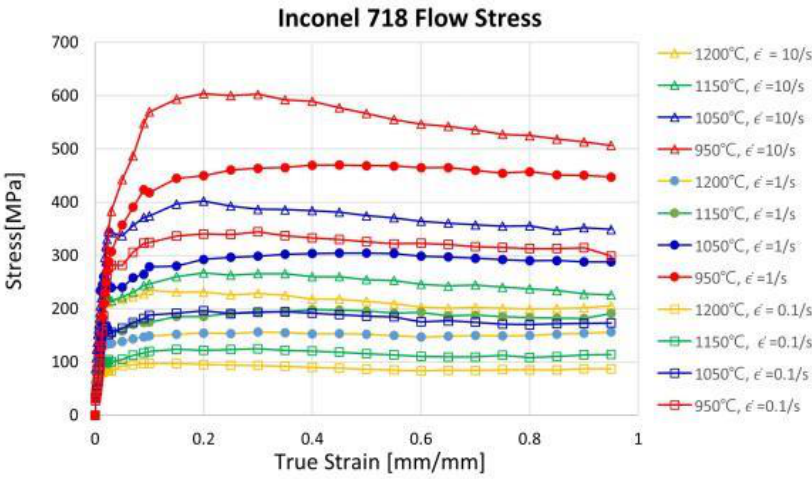
Figure 3. True stress – true strain curves of Inconel 718 from compression tests.